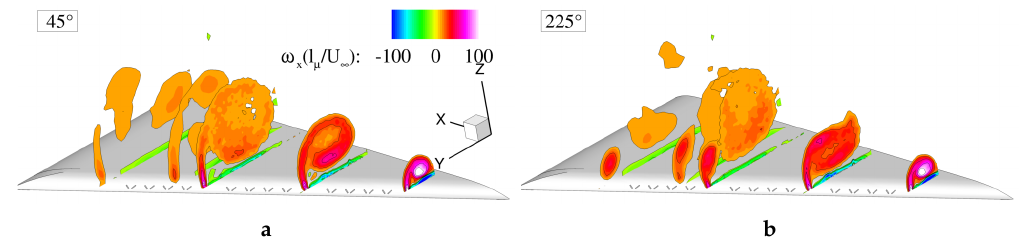
Figure 13. Phase averaged vorticity distribution at α = 35 ◦ ( a ) during blowing and ( b ) T /2 after blowing. Computed Q-criterion isosurfaces ( Q = 10 − 5 s − 2 ) of the equivalent corresponding time